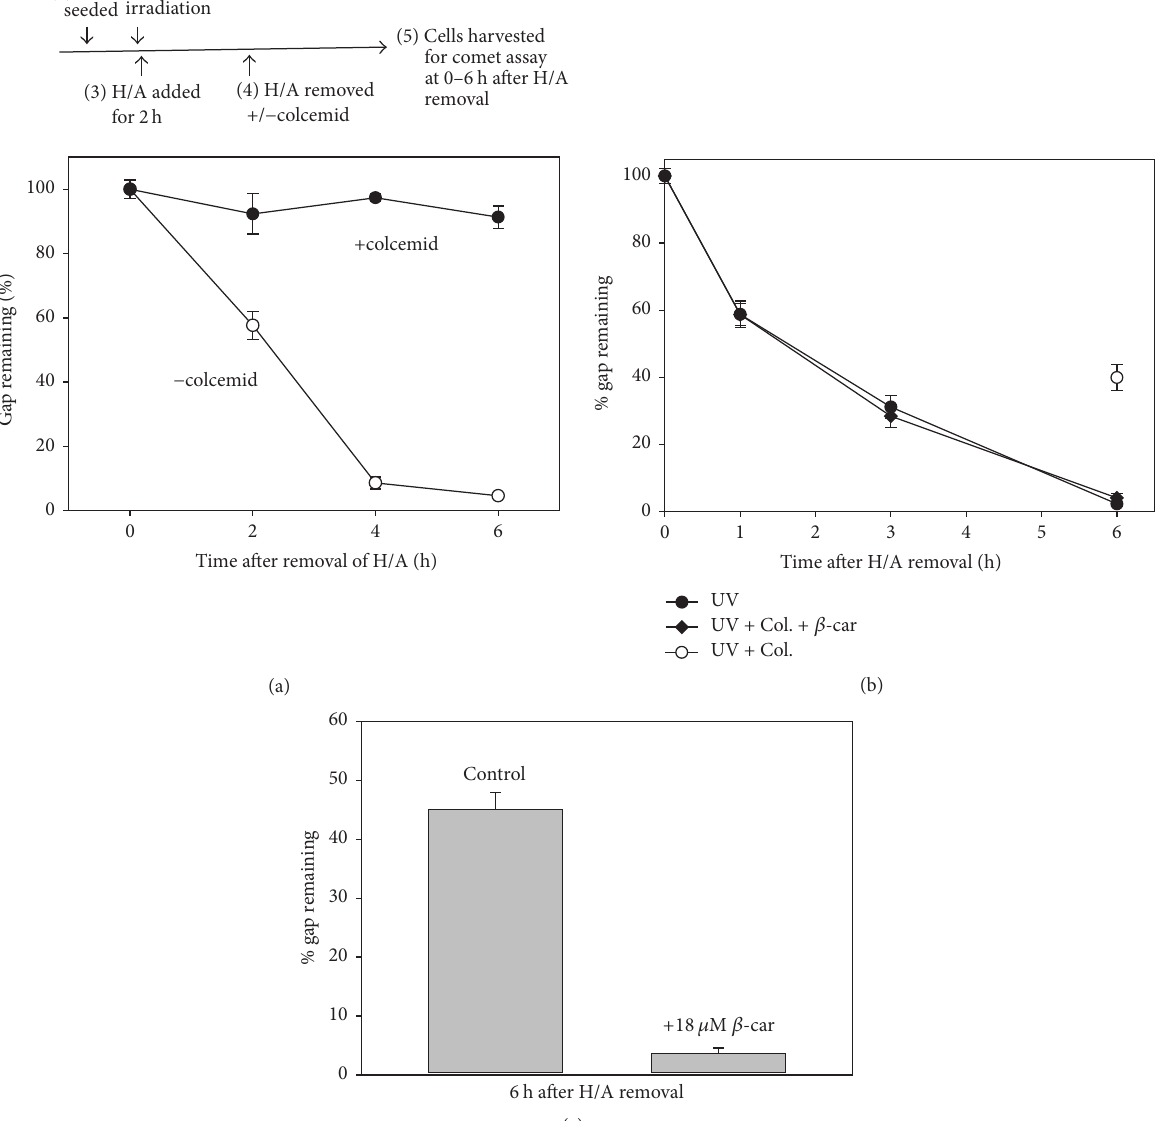
Figure 1: (a) Top: schematic illustration of experimental protocol for studying the effect of chemicals on gap-filling during repair of UV- induced DNA lesions. Bottom: colcemid delays the gap-filling. Initial level of the gaps at the time zero after H/A removal was taken as 100%. (b) Similar to (a), AGS cells in log phase were UV irradiated (3J/m 2 ) and H/A treated for 2 h. After H/A was removed, cells were treated with or without colcemid or 18 𝜇 M 𝛽 -carotene. Cells were harvested for comet assay at the indicated time. (c) Similar to (b), cells were harvested at 6 h after H/A was removed for comet